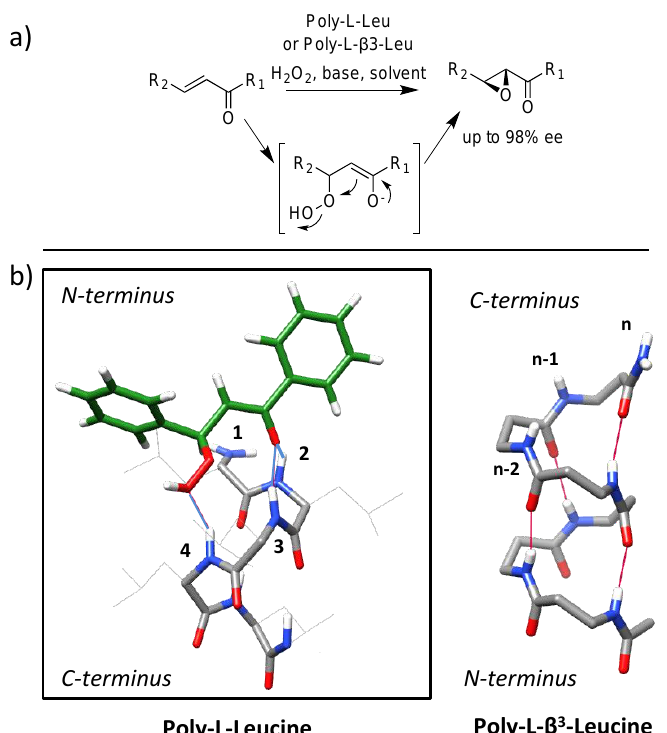
Figure 6. ( a ) Scheme of the poly-L-leucines and poly-L- β 3 -peptides-catalyzed oxidation of α , β -unsaturated ketones by hydrogen peroxide under basic conditions. The reaction proceeds through a resonance-stabilized peroxide enolate intermediate. ( b ) Left: model for the binding of the chalcone peroxyenolate to the NH-2, NH-3 and NH-4 of PLL (forest green chalcone enolate hydroperoxide; built using UCSF Chimera according to [100]). Right: the proposed binding site of poly-L- β 3 -peptides involves the amide protons n, n-1 and n-2 at the C-terminus extremity.